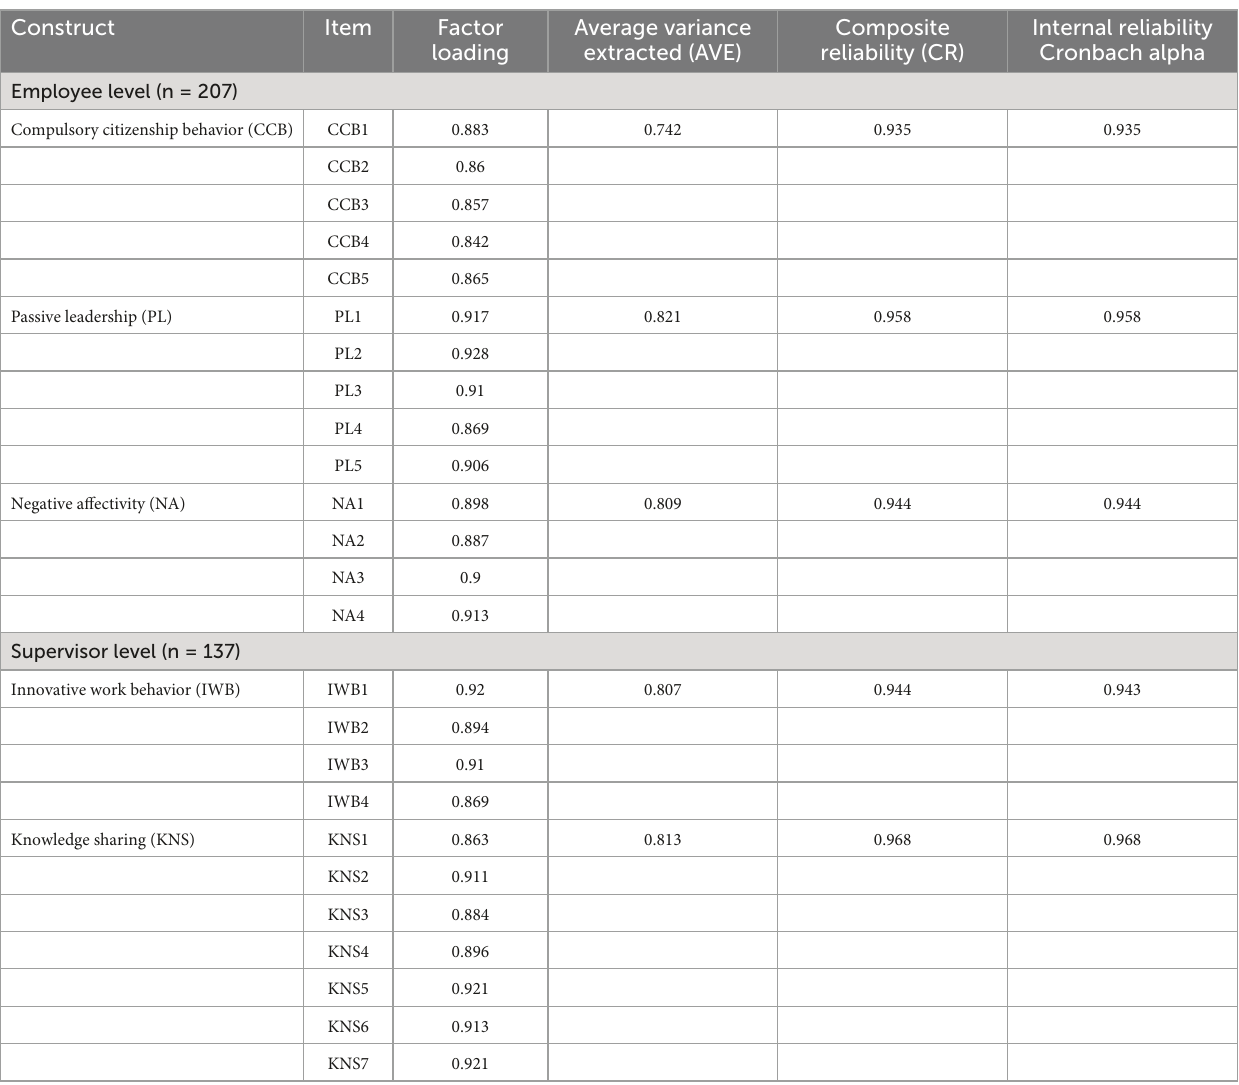
TABLE 1 Convergent validity and internal